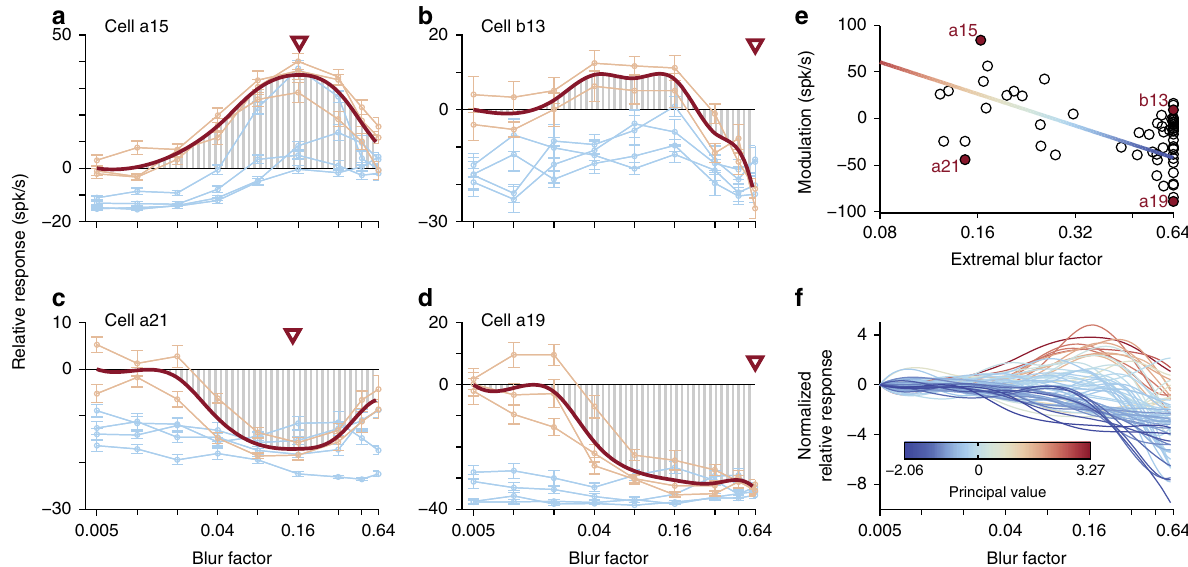
Fig. 3 Model-free analysis of blur selectivity across cells. a – d Average blur tuning curves of four example neurons (dark red) constructed by averaging responses to preferred shape stimuli (light red). Relative response ( y -axis) as a function of blur factor ( x -axis, β ) was computed with respect to mean response across sharp preferred stimuli, i.e., relative response is zero for lowest blur factors ( β = 0.005). An extremal blur factor (triangle) was de fi ned as the magnitude of blur that evoked the largest absolute deviation relative to responses to sharp stimuli. Response modulation was determined by calculating the integral of relative responses across blur factors (hatching). e Response modulation ( y -axis) is plotted as a function of extremal blur factor ( x -axis) for the population of neurons ( n = 65) in our data set. The principal value, calculated from the fi rst principal component of the population (shaded line), demarcates neurons with peak responses at intermediate blur values (more red) from those that show declining activity as blur increases (more blue). Example cells of a – d are fi lled and labeled. f Superposition of blur tuning curves computed in a – d , scaled to have a unit-variance of relative response ( y - axis) and colored according to e , demonstrate complementary tuning with respect to blur magnitude ( x -axis) within our